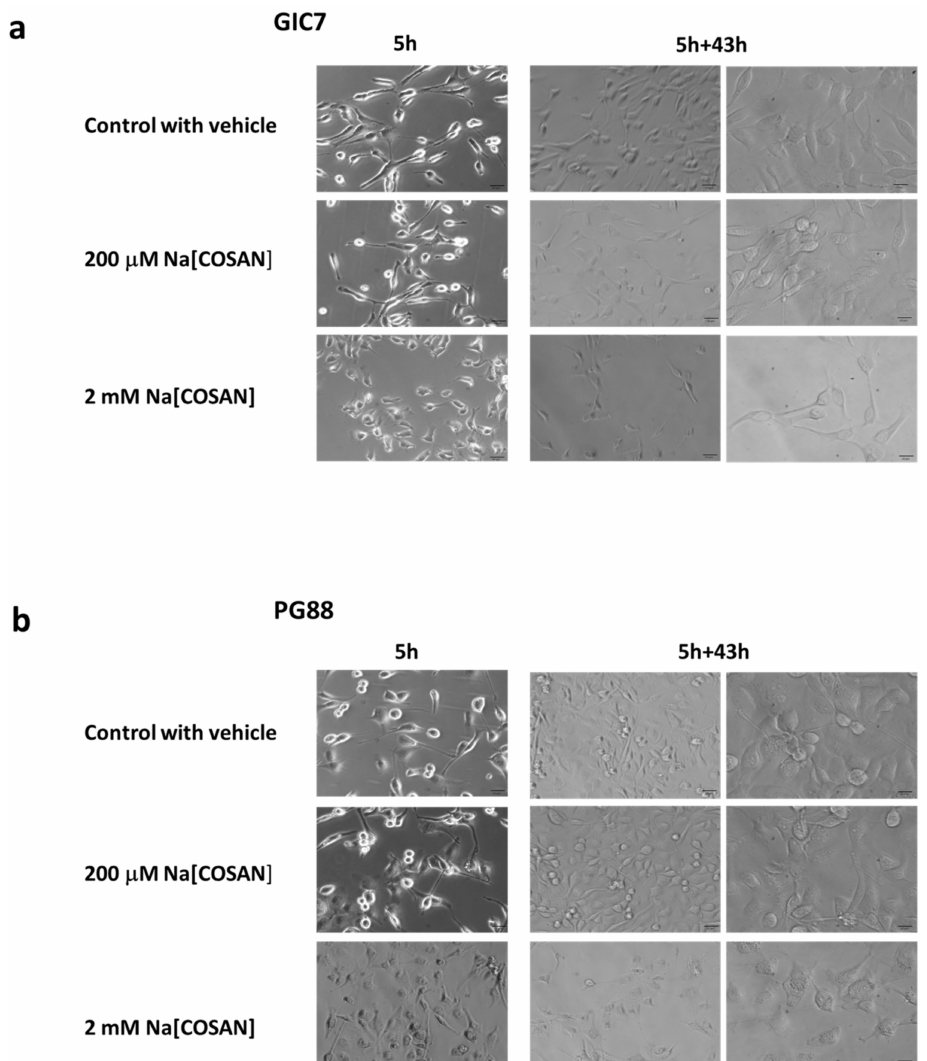
Figure 3. Morphology of glioblastoma initiating cells (GICs) treated with Na[ o -COSAN]. Microscopy comparative analysis at 5 h treatment with Na[ o -COSAN] 200 µ M and 2 mM (left panels of ( a , b ) concerning untreated cells, and 43 h after washing out Na[ o -COSAN] ( × 10 and × 20, middle and right panels magnificence, scale bars 50 µ m in left and middle and and 25 µ m, in right). Morphological changes on both GICs appear at 2 mM. GIC7 looks less affected than PG88 after 2 mM treatment and both cells show similar recovery after washing out the